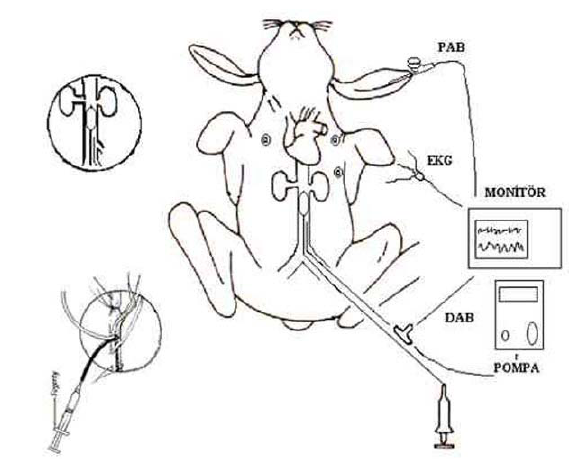
Fig. 1 - The experimental model for aortic